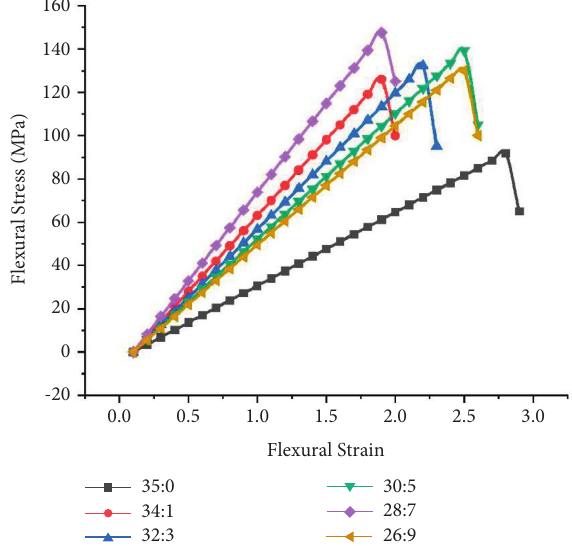
Figure 10: Flexural strain vs. flexural stress curves for epoxy resin/ madar fibre/sugarcane bagasse ash composites.